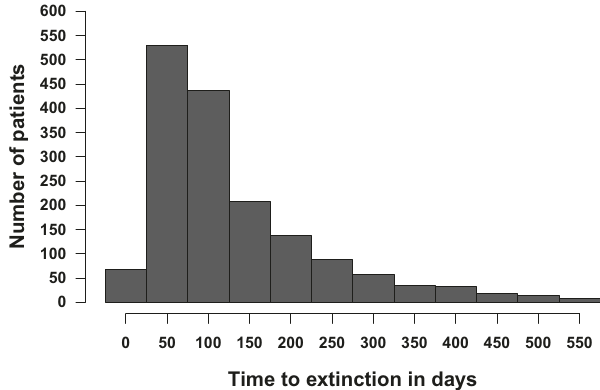
Fig. 2 Distribution of time-to-extinction for all 1924 patients. Shown is the data for all the 1646 patients who achieved bacillary population extinction; bacilli in the remainder of patients did not reach extinction, so the time is at in fi nity. The mean time to extinction and 95% con fi dence intervals were 122.4 (117.9 to 126.9)